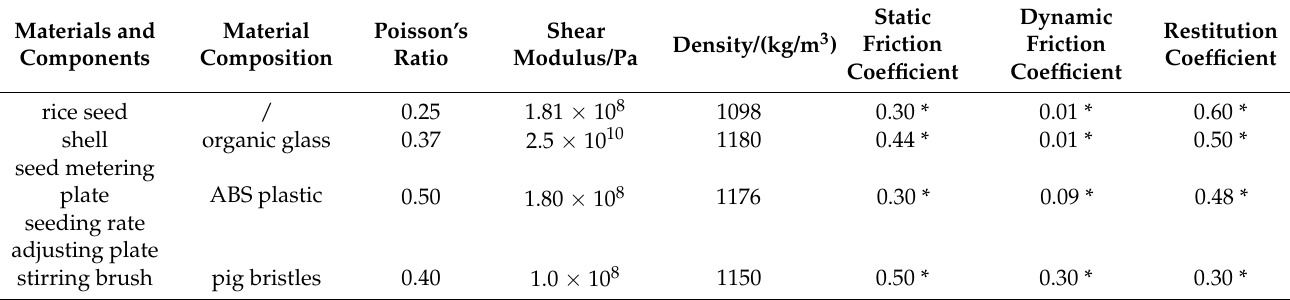
Table 2. Simulation parameter